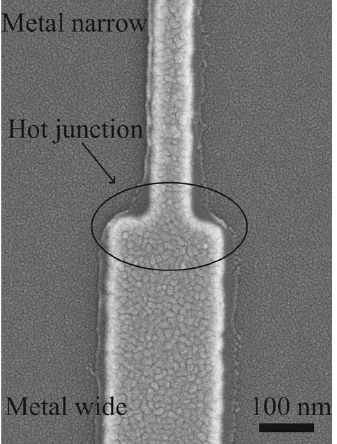
Figure 11. Fabricated thermocouple with a metal junction discontinuity (Reproduced with permission from [84], IEEE,